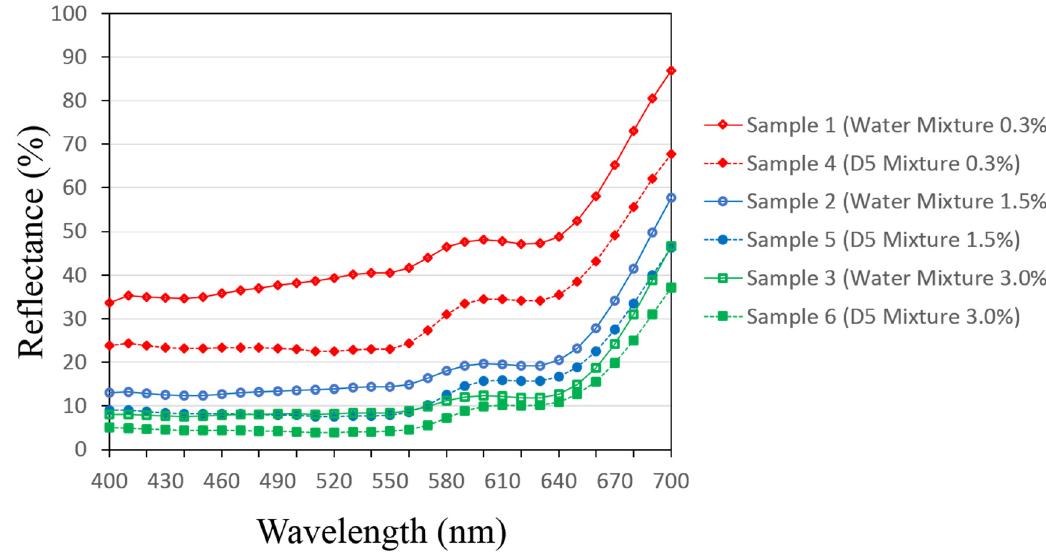
Figure 6. Reflectance curves of the color mixture of standard samples dyed in water and D5 medium.